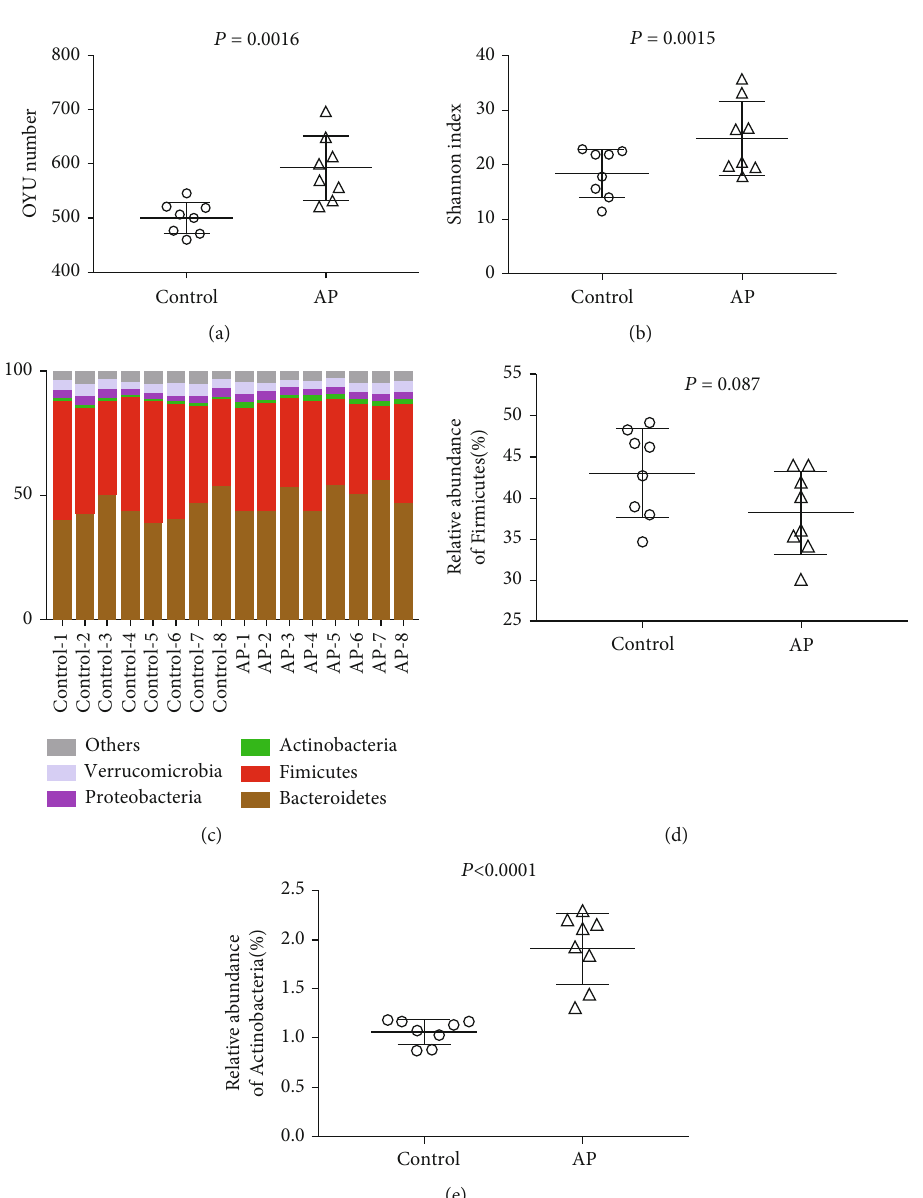
Figure 2: Results of 16S rRNA high-throughput sequencing: (a) OTU number and (b) Shannon index in the control ( n = 8 ) and AP ( n = 8 ) groups. (c) The heat map and the relative abundance of (d) Firmicutes and (e) Actinobacteria showing di ff erences in the abundance of gut microbiota in the di ff erent groups at the phylum